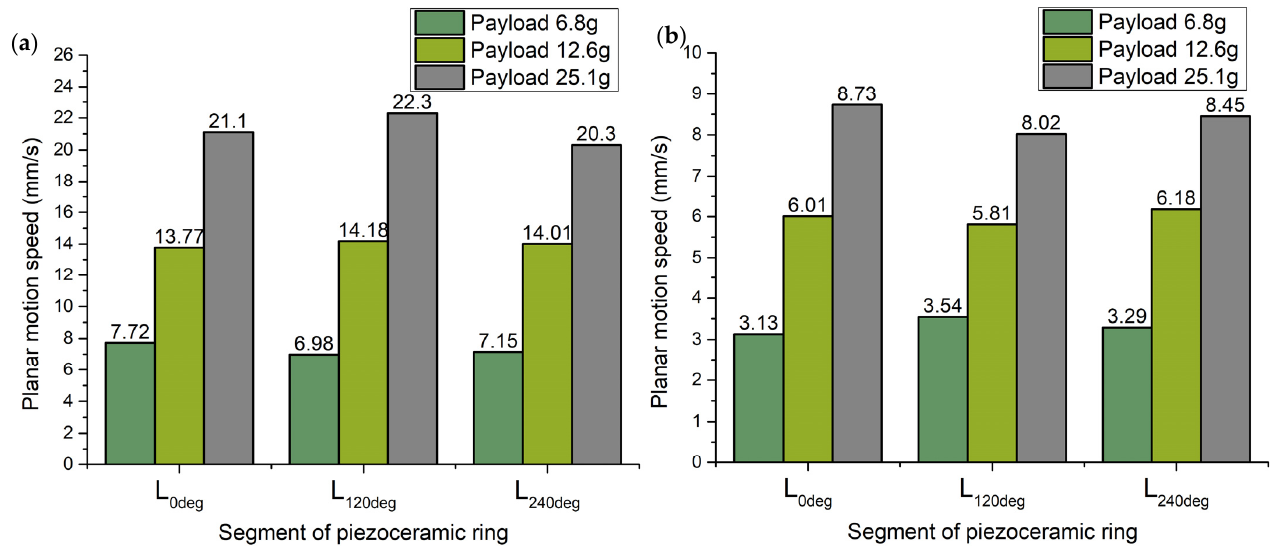
Figure 17. Comparison of measured highest and lowest planar speed values; ( a )—the highest planar motion speed values when the voltage of 200 V p-p was applied; ( b )—the lowest planar motion speed when the voltage of 80 V p-p was applied.